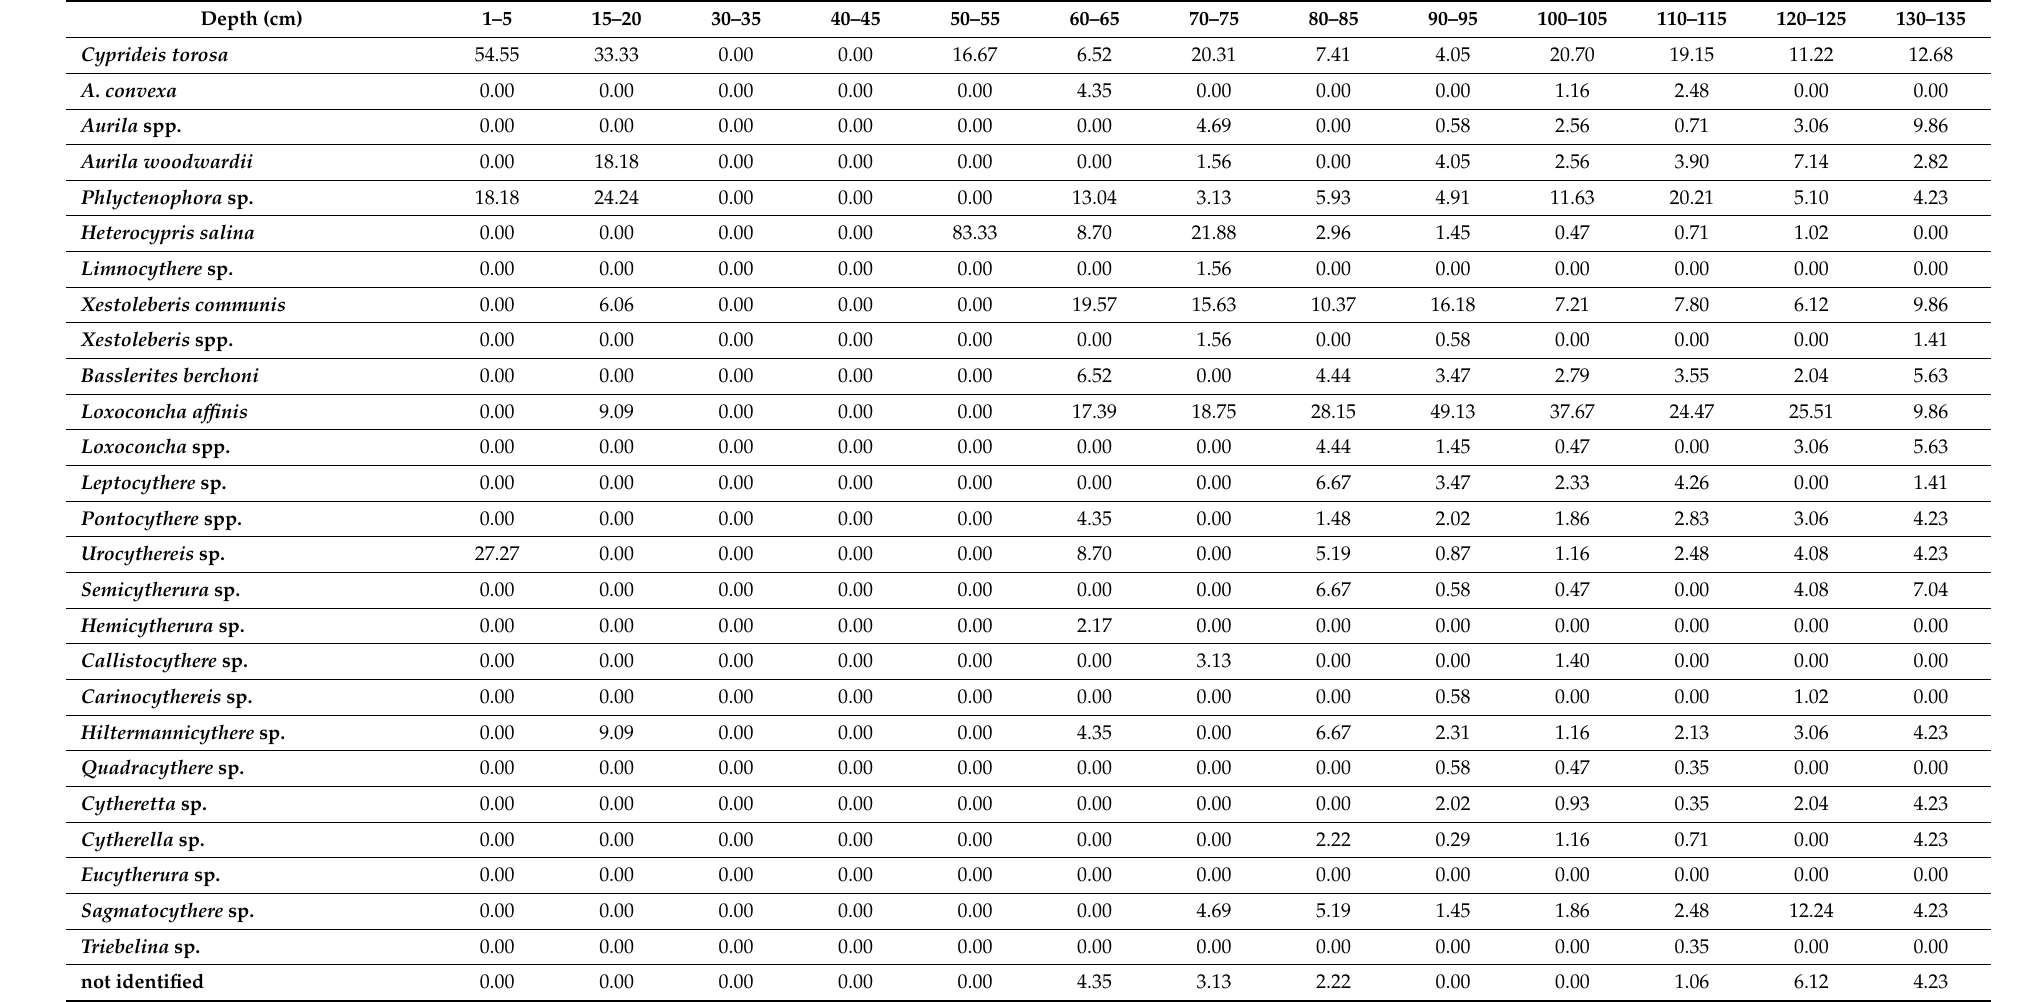
Table A4. Relative frequencies of the ostracod species in the studied samples of AKC1 (1 to 135